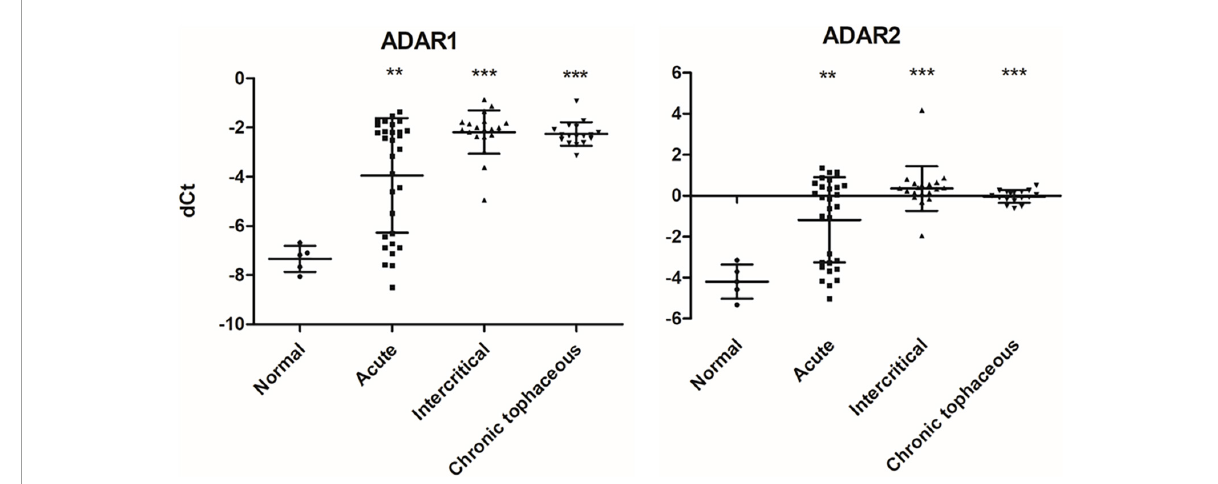
FIGURE10 RNA expressions of RNA editing enzymes were affected in patients with gout The expressions of ADAR1 and ADAR2 were detected through real-time PCR in 67 patients with gout, including 30 patients with acute gout, 20 with intercritical gout, and 17 with chronic tophaceous gout. Five normal samples were used as the control. Lines represent medians, and error bars represent standard deviation. ** P < 0.005, *** P < 0.0001 by Student’s t -test, compared with normal samples. RNA expression levels are shown as dCt ( ALAS1 as internal control).